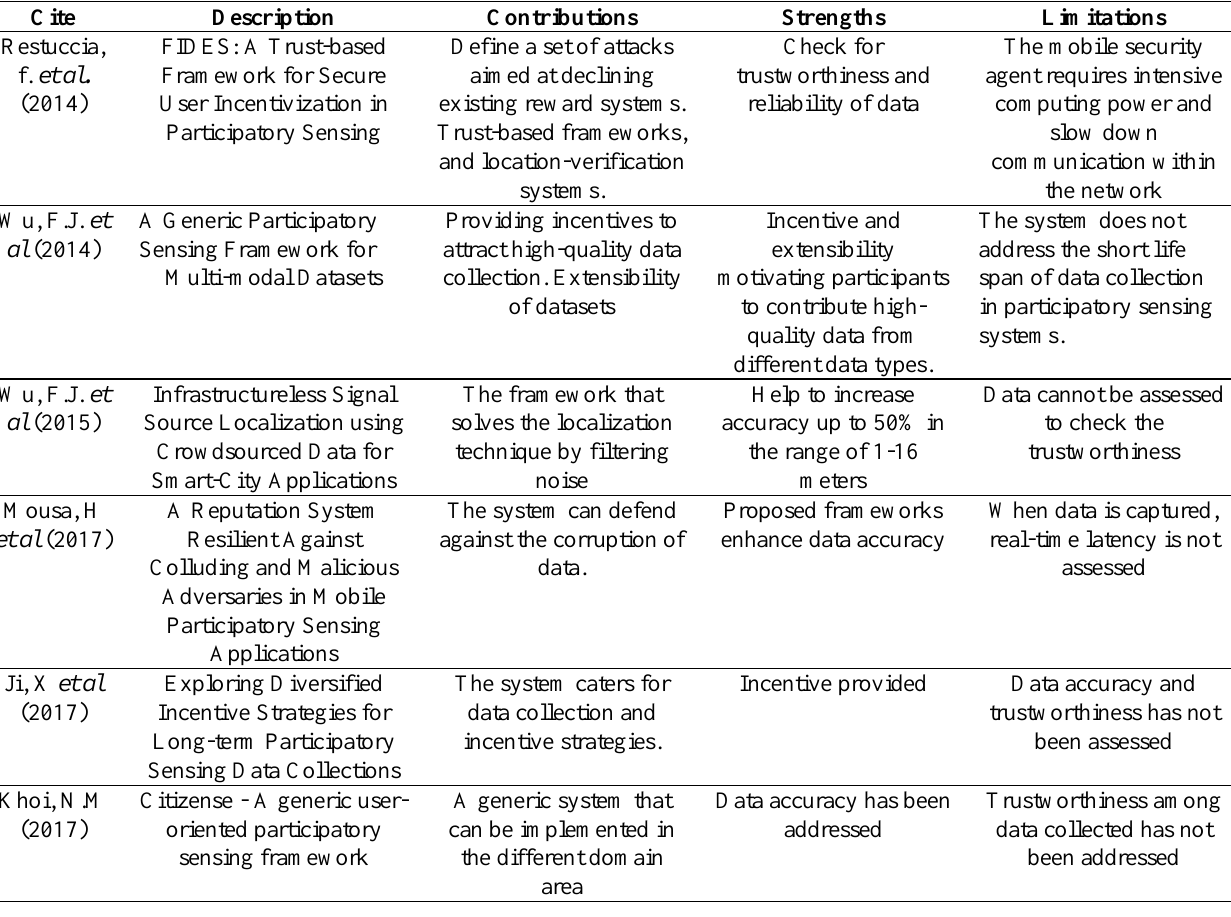
Table 3. People-Oriented Participatory Sensing